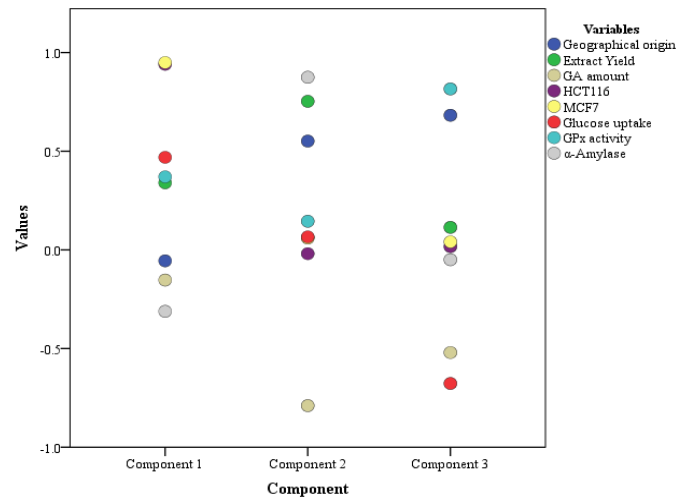
Figure 3. distribution of data variables in components with expected values. Figure 3. Distribution of data variables in components with expected values.